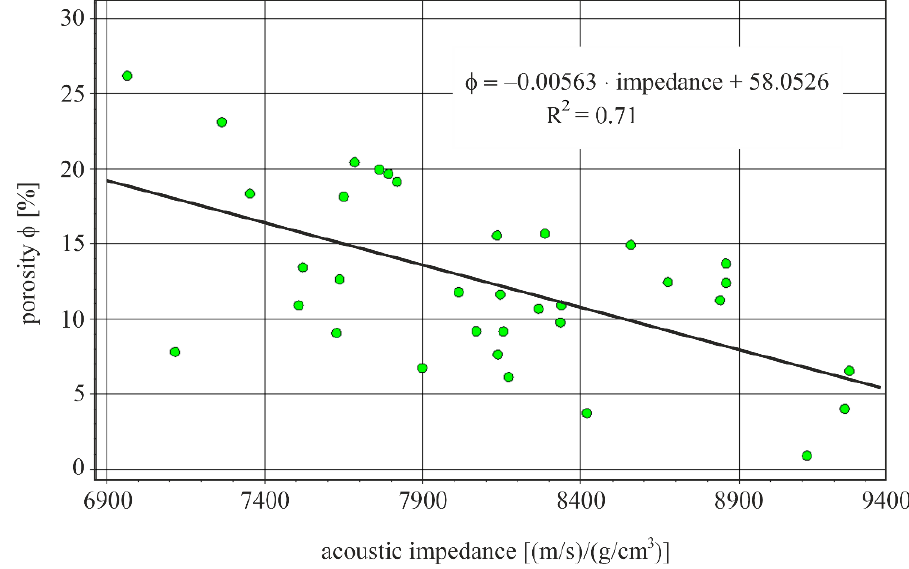
Figure 12. Relationship between porosity and acoustic impedance for wellbore O2.